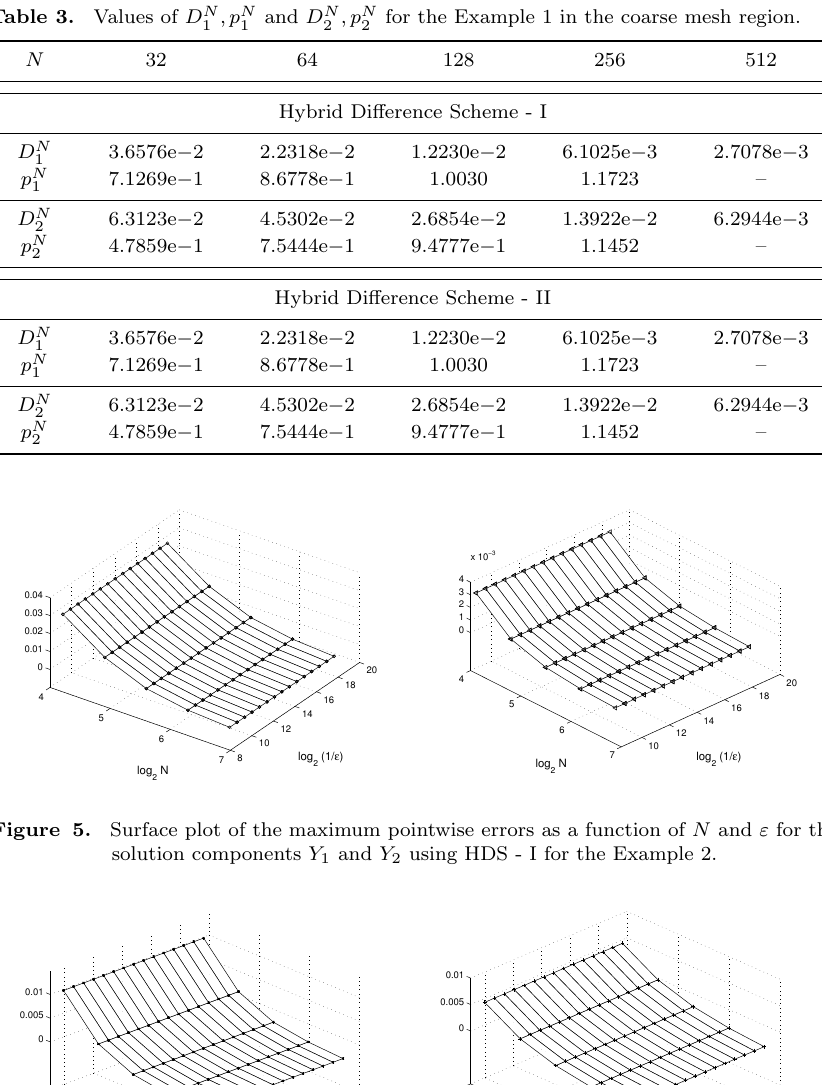
Table 3. Values of D N